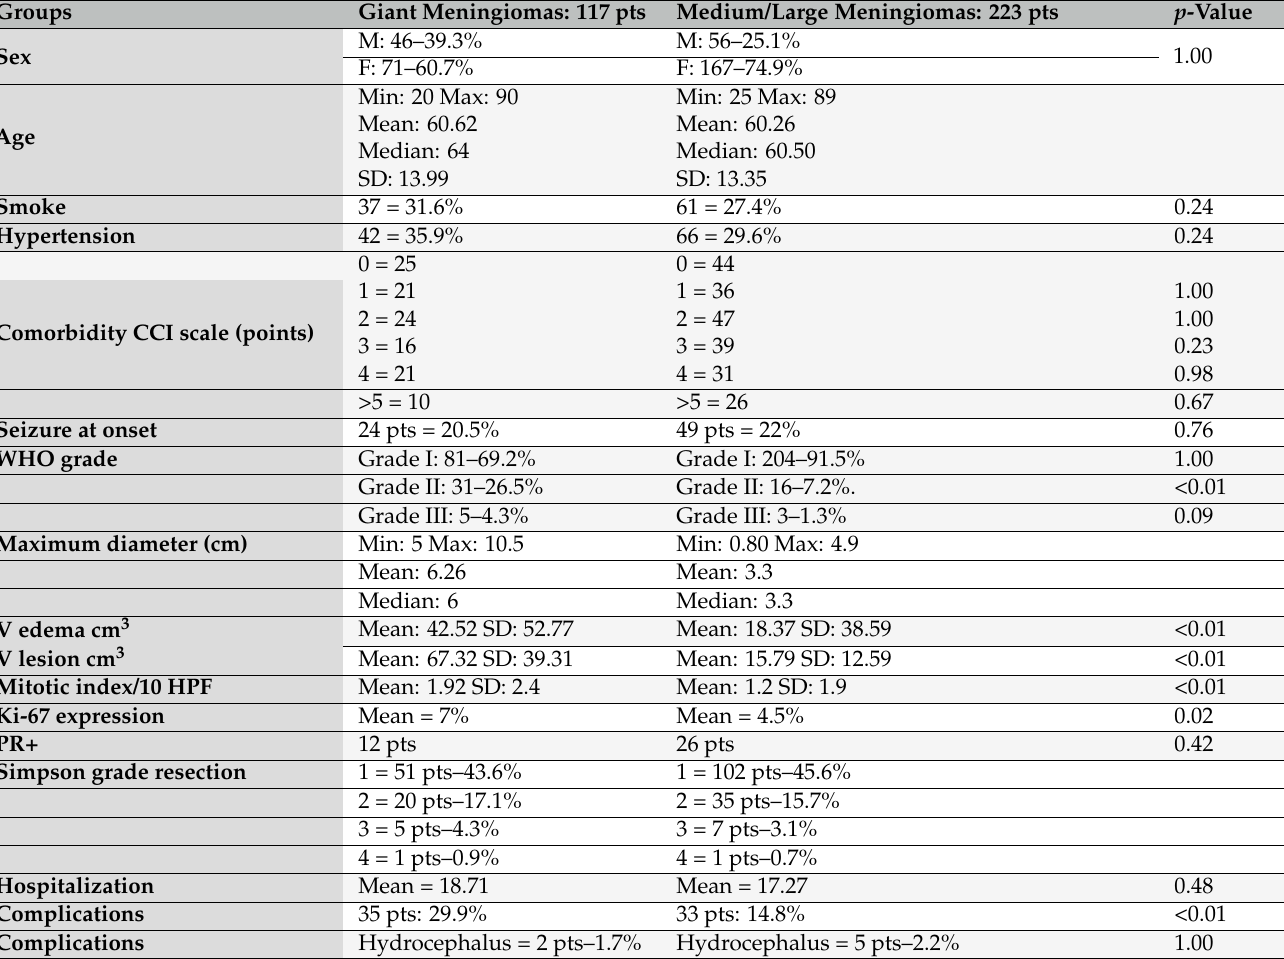
Table 2. The main clinical, radiological, and outcome variables examined in the study comparing giant and medium/large